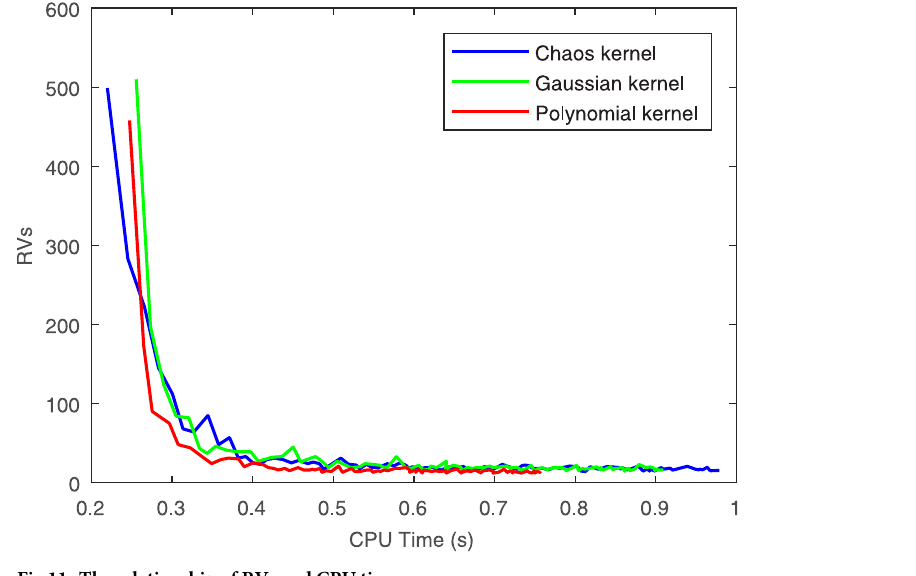
Fig 11. The relationship of RVs and CPU